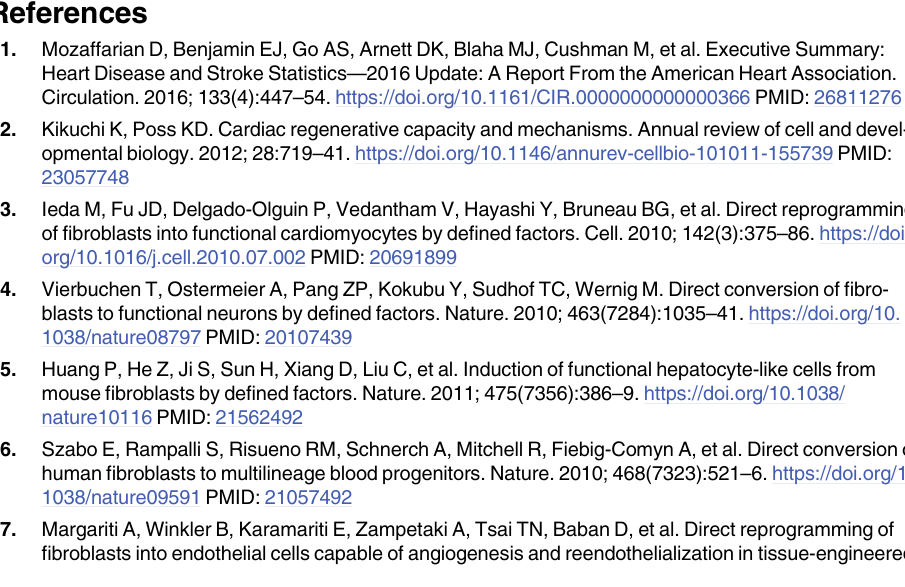
S1 Table. TaqMan 1 primers used in single-cell